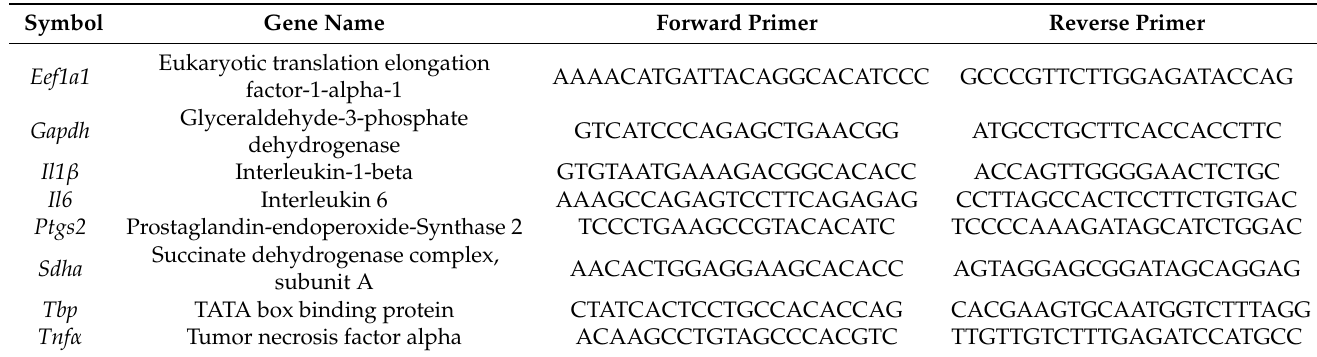
Table 1. Primer sequences for reference genes (pressure, Eef1a1/Sdha ; tension, Gapdh/Tbp ) and target